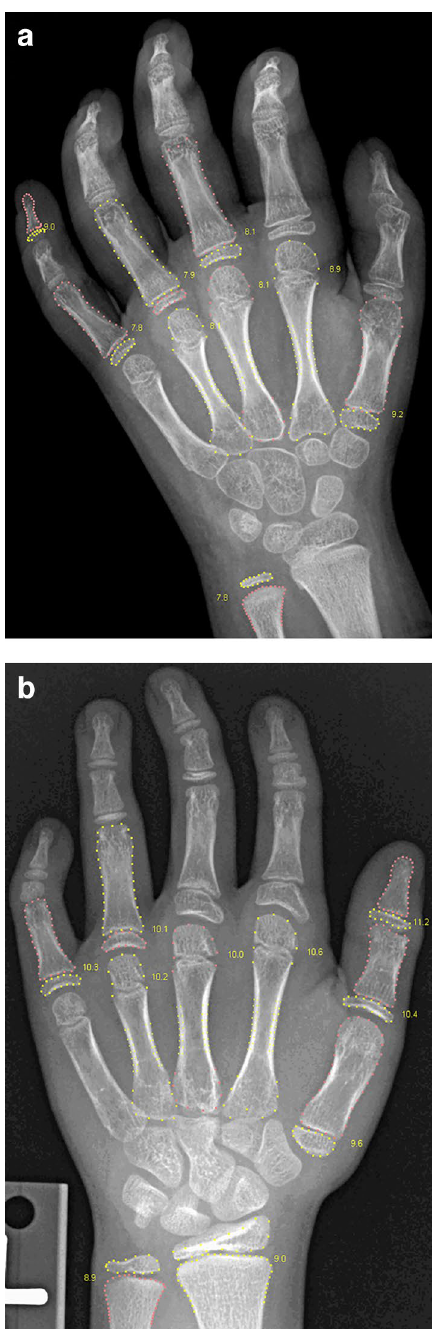
Figure 6. Females 2707 and 3781 from the RSNA study. The automated method accepted only 9 and 10 of the 21 tubular bones, which was just above the 8 bones needed for the entire analysis to succeed. In the first image, the overlap between radius and lunate is likely to have caused radius to be rejected; and the pose of the middle and distal phalanges in finger 2–4 is incorrect due to flexion. In the second image, there is brachydactyly in the second and fifth middle phalanges, and the second and third proximal phalanges have thick epiphyses, suggesting the monogenic disorder Brachydactyly Type C. For clarity, the bone contours are drawn in alternating colours. The numbers indicate the GP bone